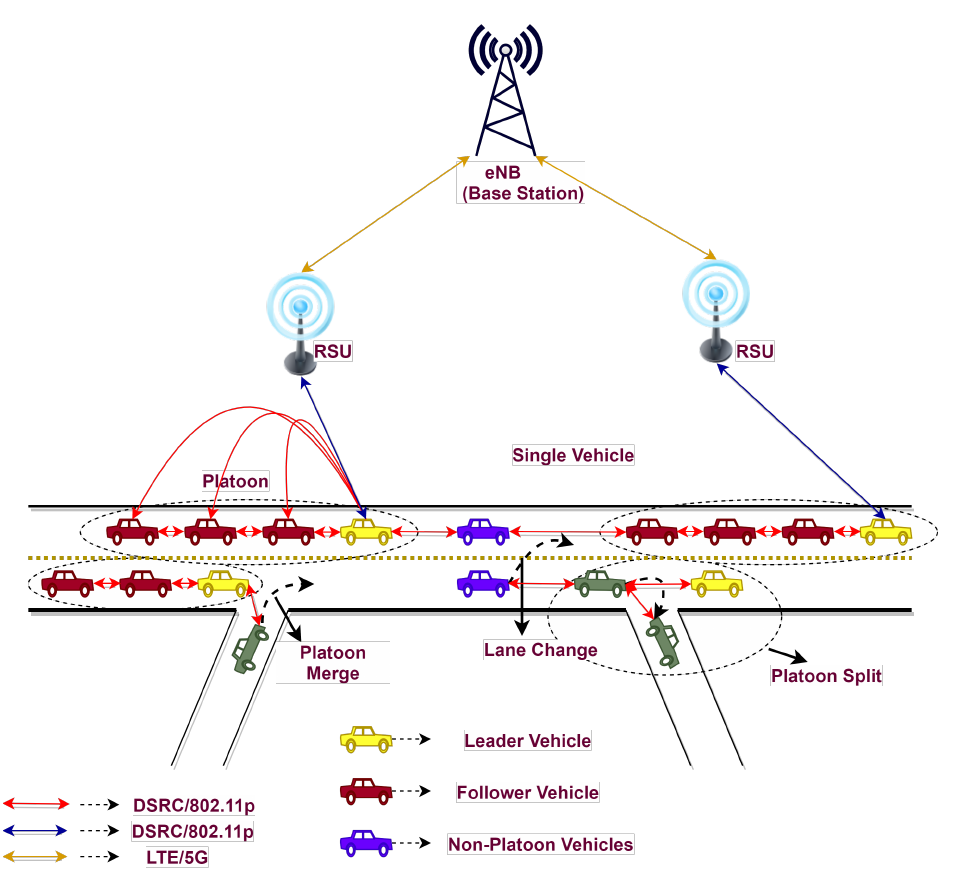
Figure 1. Platoon